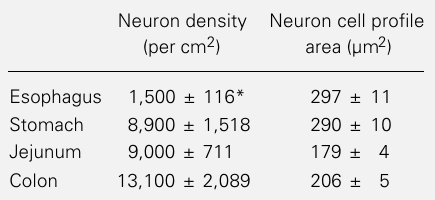
Table 1 - Number and size of myenteric neurons from the digestive tract of Calomys callosus . Data are reported as mean – SEM. The neuron cell profile area was evaluated in 300 nerve cell perikarya for each segment. See Figure 3 for dis- tribution of cell areas. *P<0.05 compared to the other